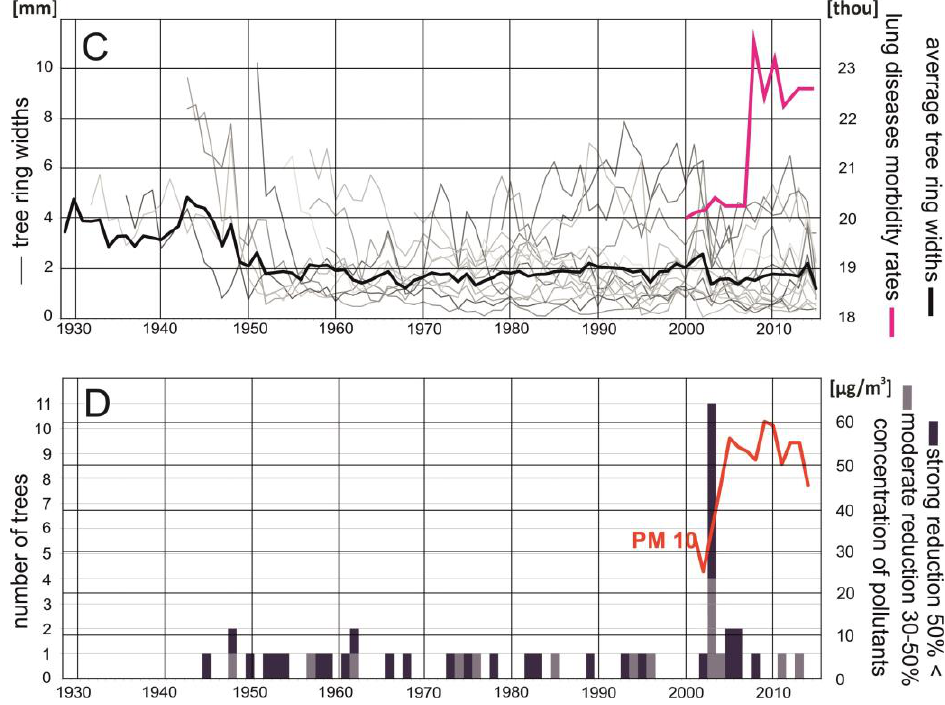
Fig. 3. Dendrochronological data for the Sucha Beskidzka study site: tree-ring widths (C) and number of trees showing the beginnings of ring reductions (D) compared to lung diseases morbidity rates and air pollution level in Sucha